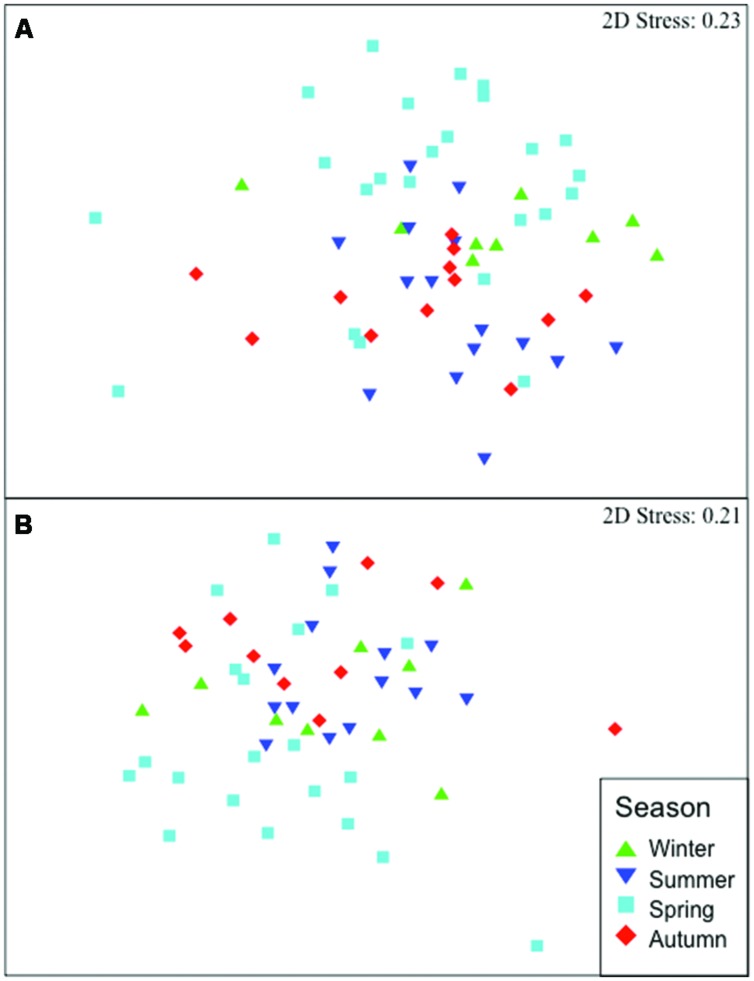
Non-metric multi-dimensional scaling (nMDS) plots of bacterial community similarity in Didemnum fulgens over the 16 months of study and for each season. nMDS ordination based on Bray-Curtis similarity of T-RFLP profiles for HaeIII
(A) and MspI
(B) datasets. Stress values (goodness-of-fit between two-dimensional ordination distances and similarity matrix distances) are shown in parenthesis for each enzyme (range = 0 to 1, lower values = better fit).